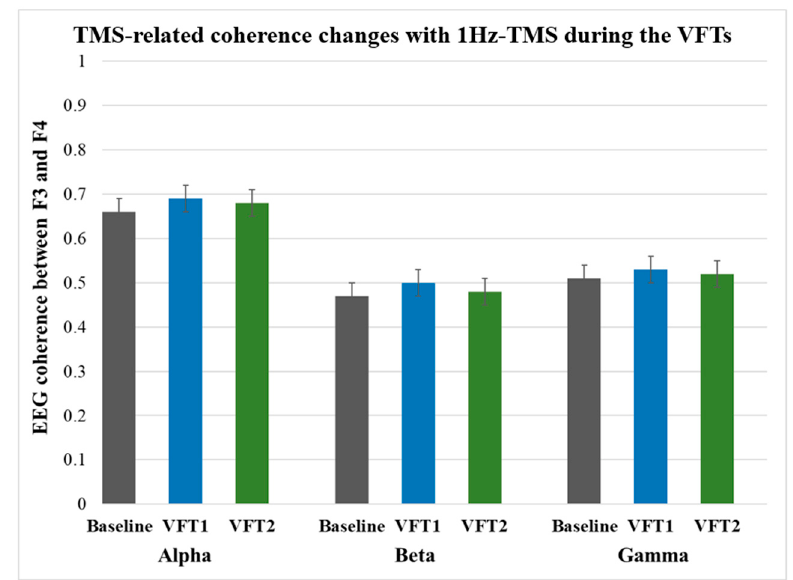
Figure 6. TMS-related coherence changes during the VFTs. The ANOVA showed no significant changes in coherence for all frequency bands during the VFT-1 (alpha: F 1,20 = 3.16, p = 0.101; beta: F 1,20 = 3.73, p = 0.077; gamma: F 1,20 = 3.23, p = 0.098) or VFT-2 (alpha: F 1,20 = 1.41, p = 0.258; beta: F 1,20 = 1.69, p = 0.217; gamma: F 1,20 = 0.497, p = 0.494).